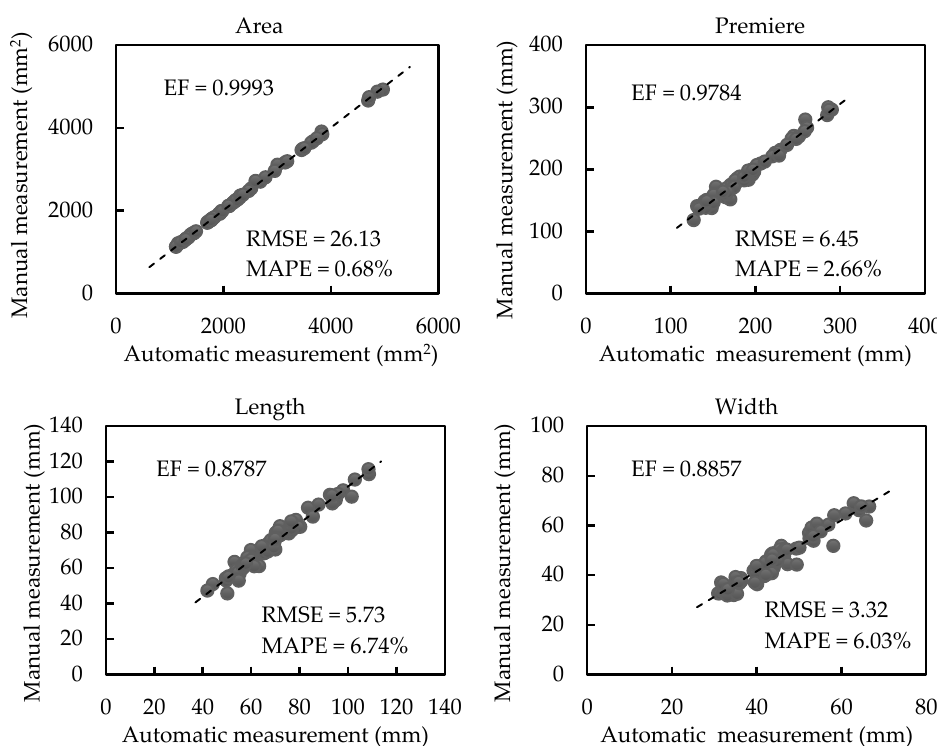
Figure 9. Regression analyses between automatic and manual measurements of scale-related traits of plants with medium occlusion (plants in group 3).